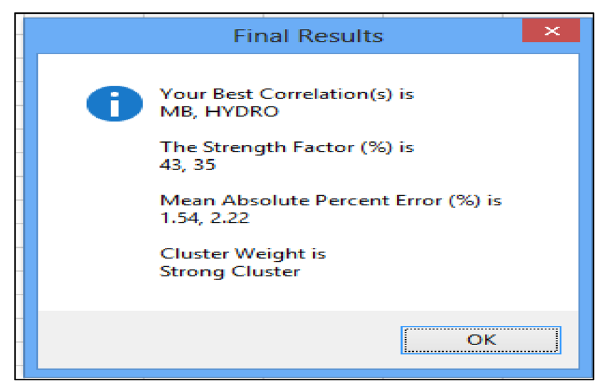
Fig. 4 Expert system best correlation/strength factor/mean absolute percent error output window